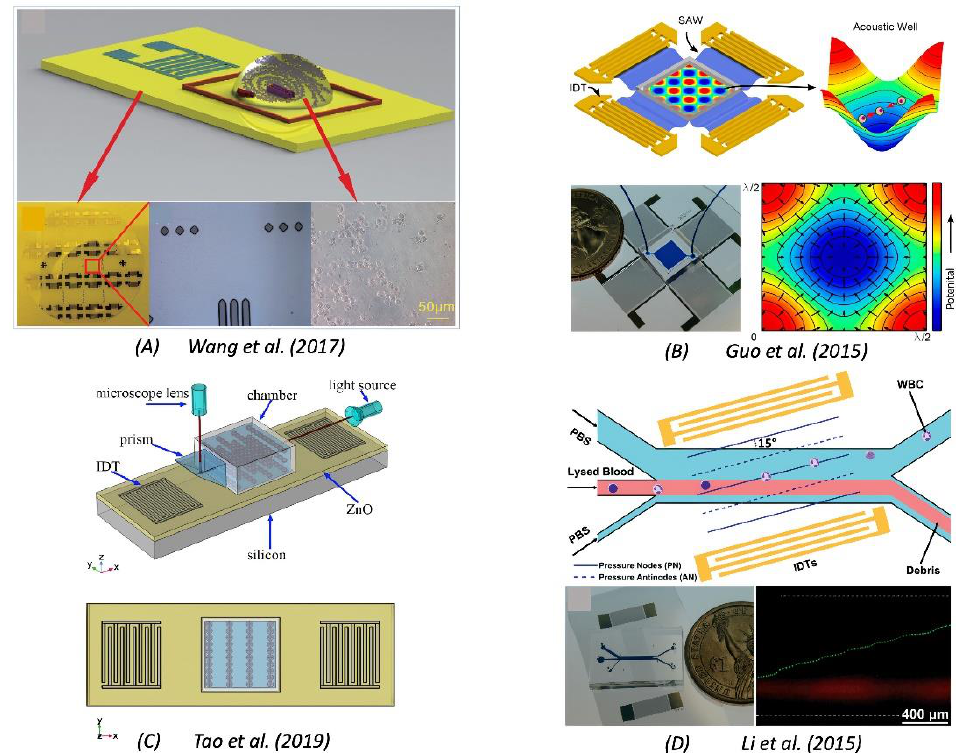
Figure 26. Various mechano-biological applications using SAW devices [37,200–202]. ( A ) SAWs for the purpose of cell lysis on a 128 ◦ YX-cut lithium niobate wafer, ( B ) controlling the cell–cell interactions by administering four orthogonal IDTs at a 45 ◦ angle to the X-axis of the 128 Y-cut lithium niobate substrate, ( C ) ZnO/Si thin films surface acoustic waves for the manipulating and 3D patterning of yeast cells and microparticles, ( D ) 15 ◦ tilted microfluidic channel with interdigitated electrodes on a 128 ◦ YX-cut lithium niobate wafer to generate a standing